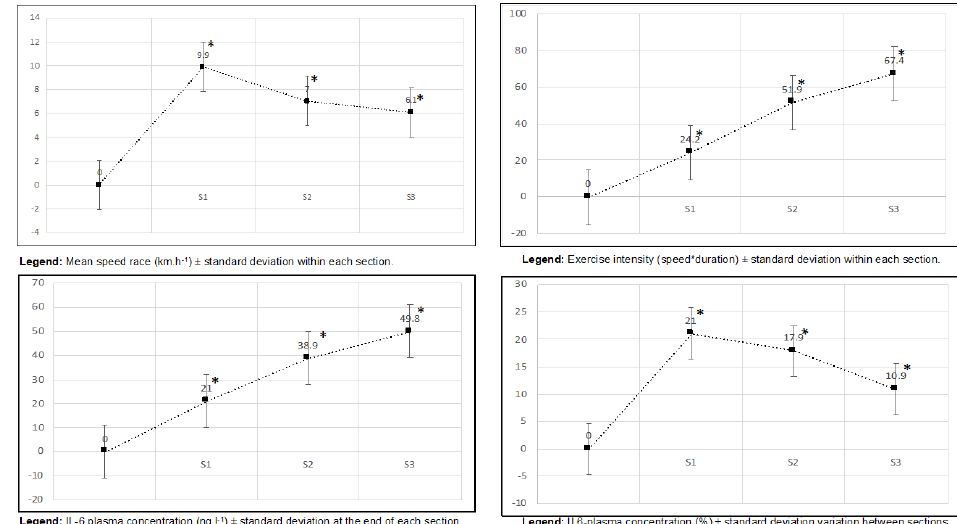
Figure 1. Evolution of speed race, intensity, IL_6 absolute and relative variations among the different sections. Data are expressed as mean ± SD. * means significant difference vs. S1 ( p <